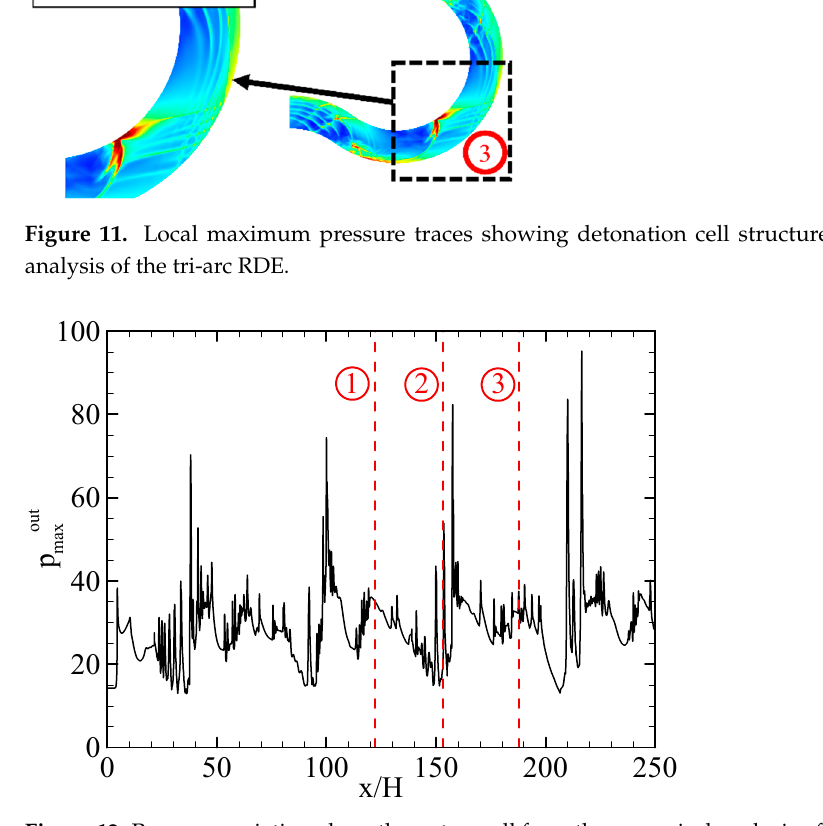
Figure 13. Pressure history at the concave corner (p1) for the mass flow rate m(cid:4662) = 80.3 g/s.